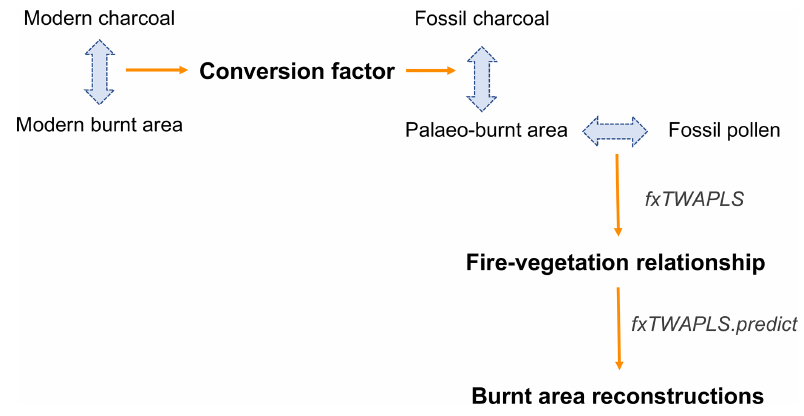
Figure 1. Flow chart of the methodology of burnt area